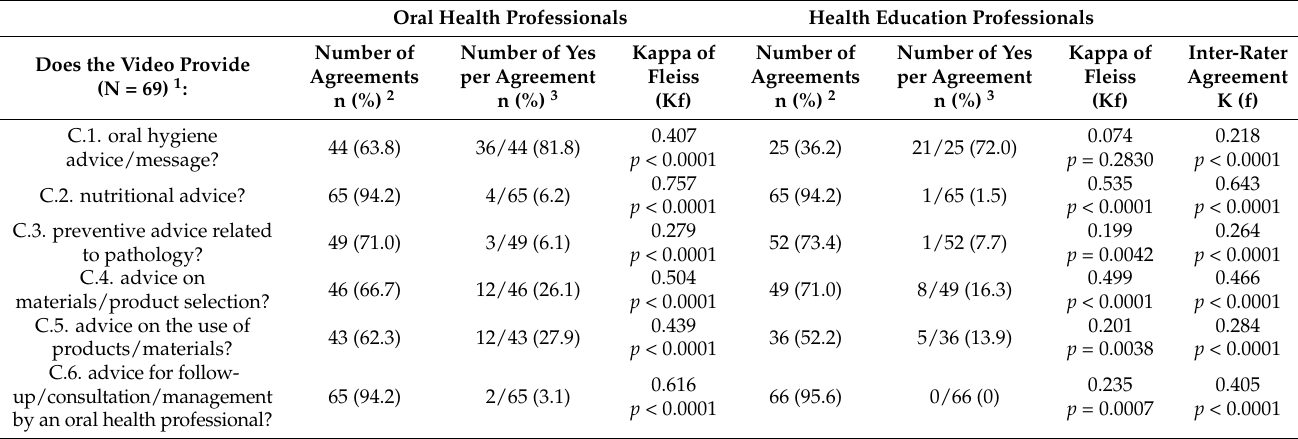
Table 3. Intended objectives of the Tik Tok videos corresponding to